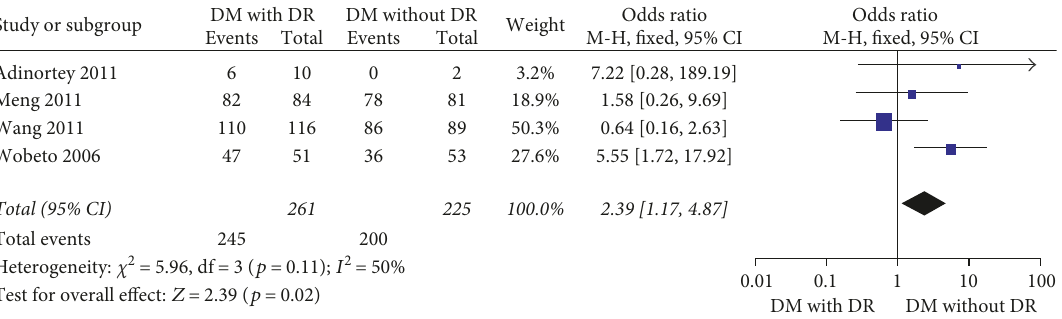
Study or subgroup